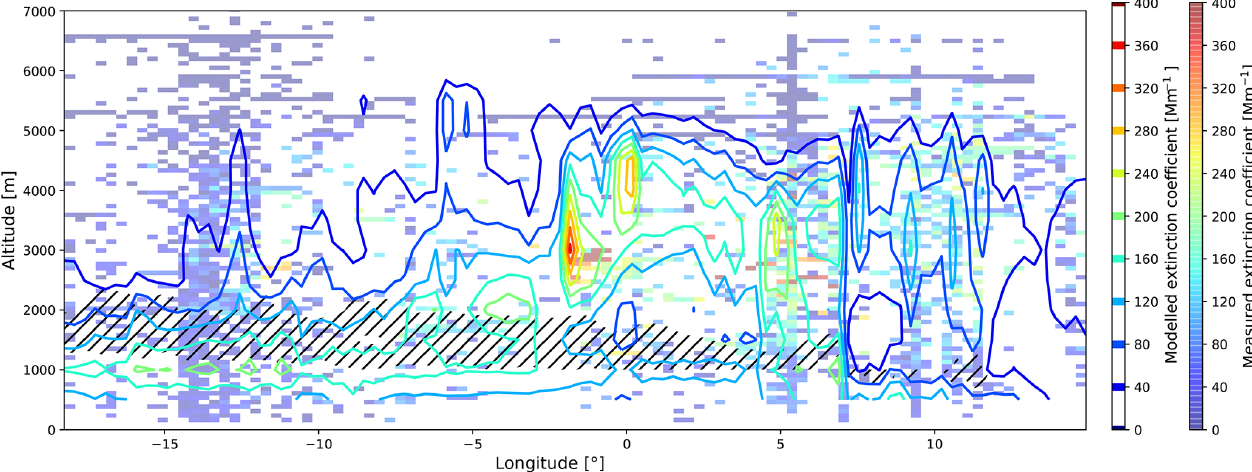
Figure 2. Mean along-flight-track vertical distribution of the aerosol extinction coefficient along longitude. The contour lines show the mean collocated model extinction coefficient profile along with the location of the aircraft. The pixels represent the mean value of the aerosol extinction coefficient from the CLARIFY and ORACLES (2016, 2017) campaigns. The hashed lines illustrate the model cloud location by using cloud liquid water content from the model. Note that the modelled extinction is for ambient relative humidity, whereas the measured extinction is for dry aerosols with relative humidity below 30%. The same colour map is applied for measurement and model results to facilitate